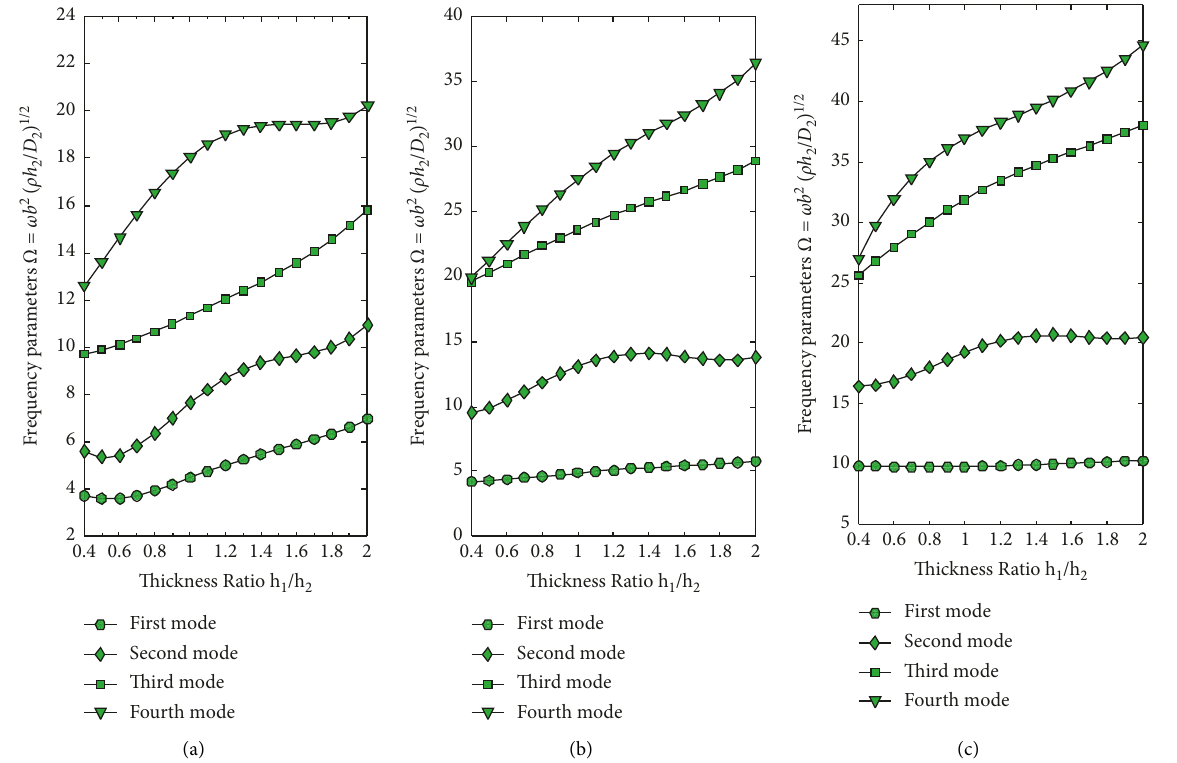
������ 􏽰 ρ h versus step thickness ratio h / D 2 2 / b � 0 . 4, and plate thickness ratio h 1